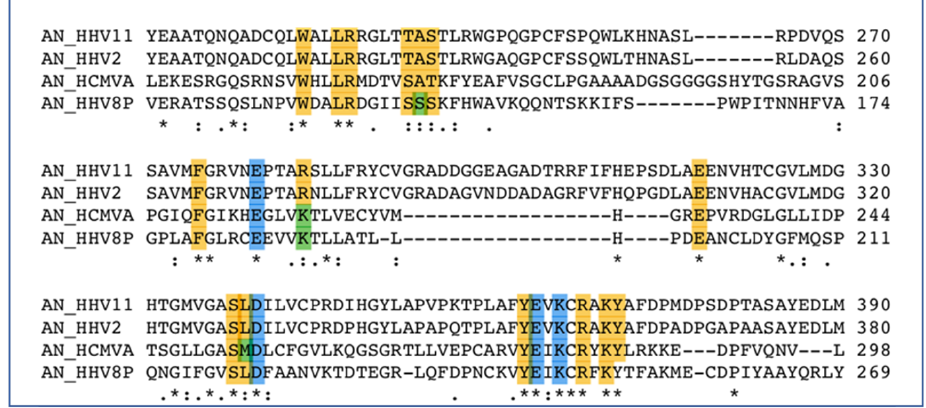
Figure 3. Active site sequence alignments of alkaline nucleases from HSV-1, HSV2, CMV and KSHV. Key metal binding EDEK residues highlighted in blue, other conserved active site residues not involved in metal binding are shown in yellow and green, where green indicates notable variations between family members. Asterisk denotes identical residues, colon denotes homologous residues and period denotes a low level of similarity.